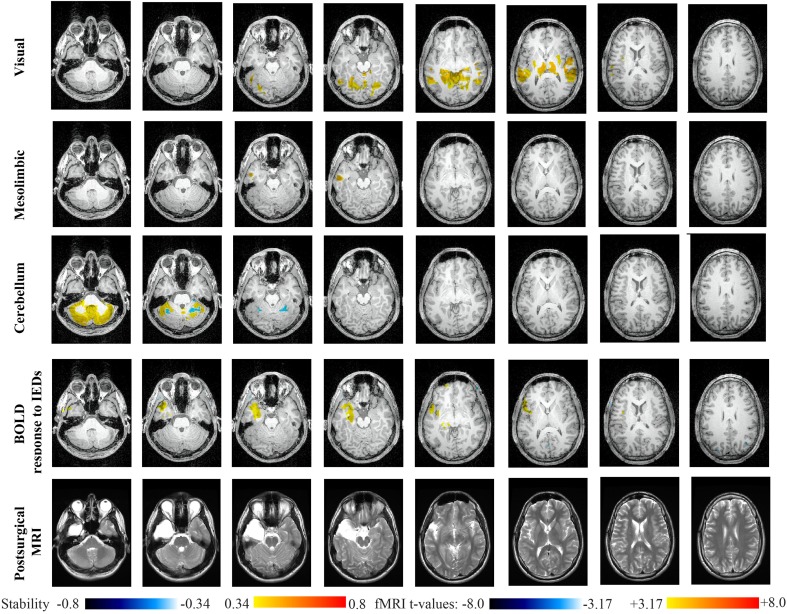
Evaluation of DANI on Patient 3 with left MTLE. Results are presenting most salient stability changes observed in Cmapn followed by a t-map of the BOLD response to epileptic discharges and a postsurgical T2 MRI, all resampled in the native anatomical MRI space of the patient. Most salient stability changes observed for Cmapn of Visual, Mesolimbic and Cerebellum networks are presented. The Visual and Cerebellum networks were also involved in significant interactions of modularity changes at p < 0.001. Same colormap conventions than in Figure 6.